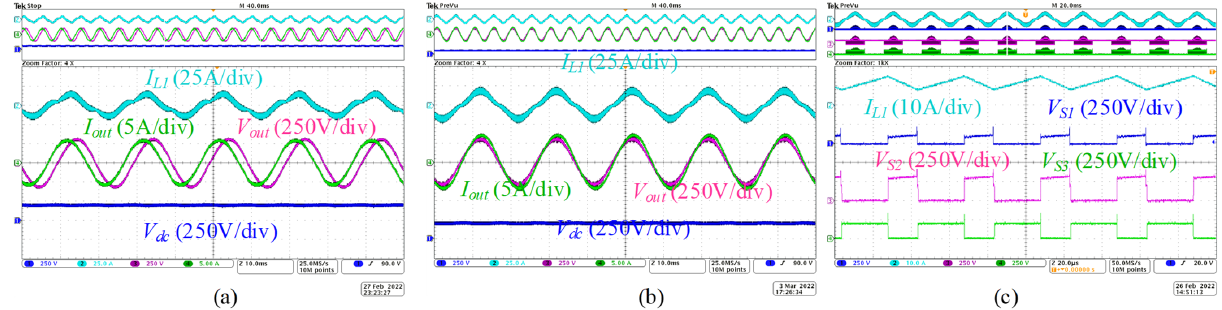
Figure 12. Experimental results in transient conditions: I L at the input voltage of 200 V; ( a ) step change in peak value of output voltage from 220 V to 325 V and output power change from 0.5 kW to 1 kW, ( b ) step change in peak value of output voltage from 325 V to 220 V and output power change from 1 kW to 0.5 kW, and ( c ) I out , I L top to bottom with the input voltage of 400 V and output power of 1.5 kW in the transient condition from symmetric to asymmetric operation mode and vice versa.